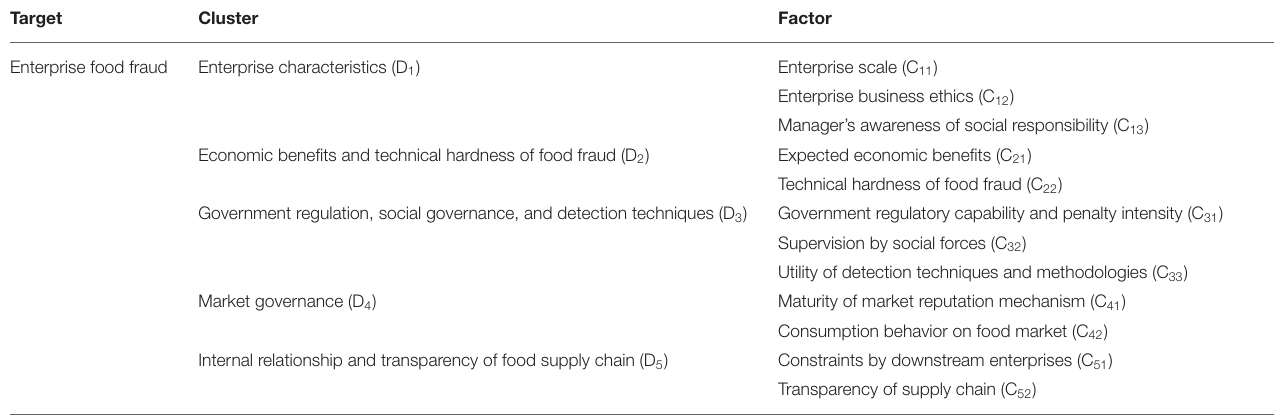
TABLE 1 | Key clusters and factors influencing enterprise food